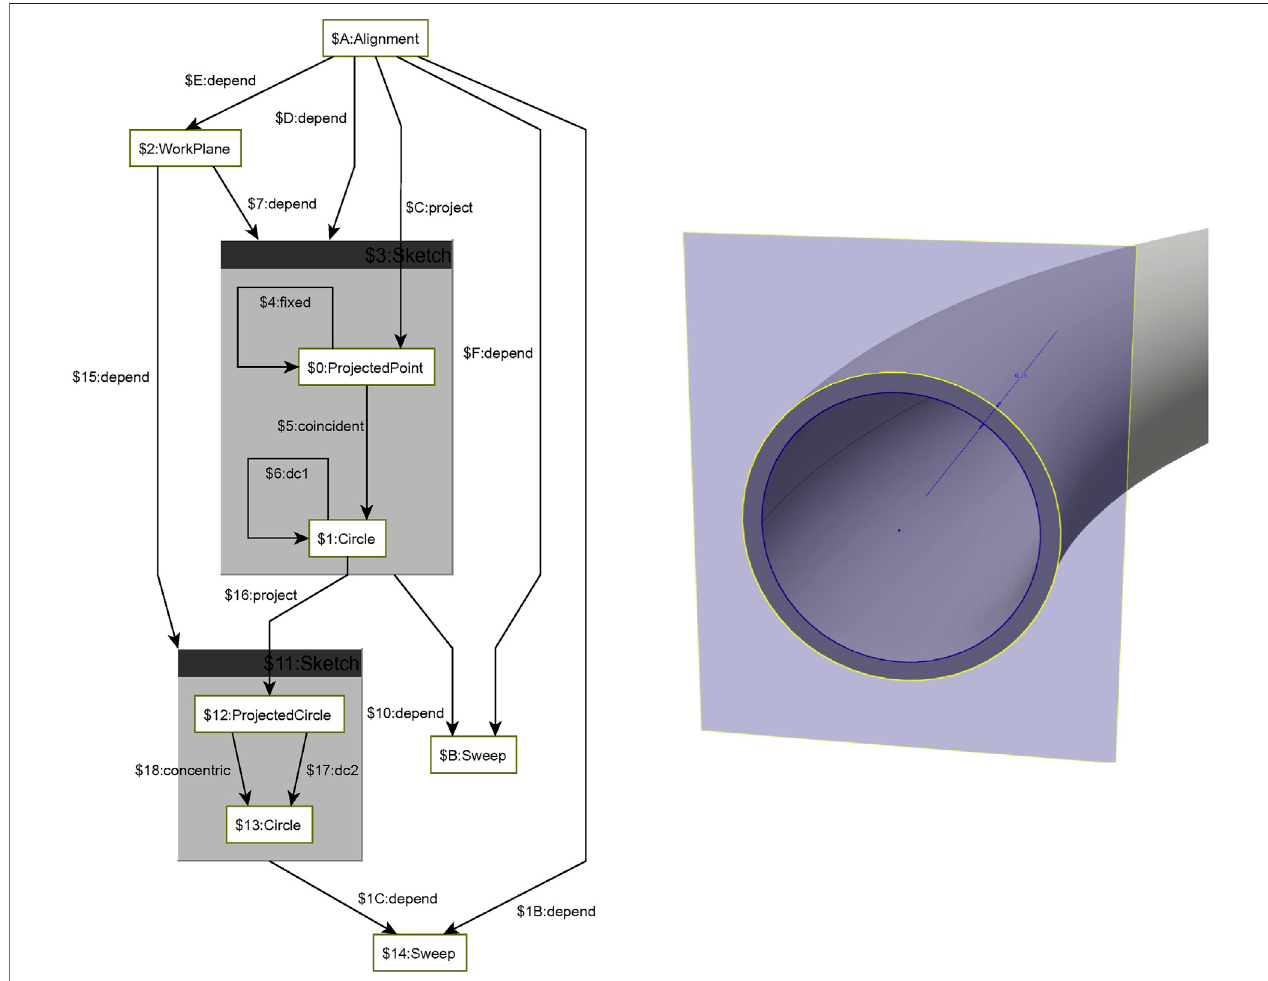
FIGURE13| Astageinthegraph-driven designdevelopmentprocesspresented inVilgertshoferandBorrmann(2017).Left-handside:Graphstructure consisting of entities and procedural operations, created by graph transformation. Right-hand: Interpretation of the graph by a parametric CAD system.